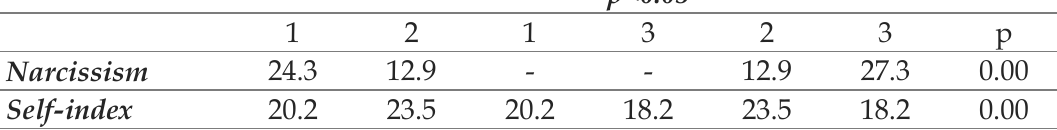
Table 1. Statistical differences between integrative indicators of narcissistic self-regula- tion in every cluster. Comparison of signi (cid:192) cant differences between every cluster mean of integrative indicators (1:2:3);